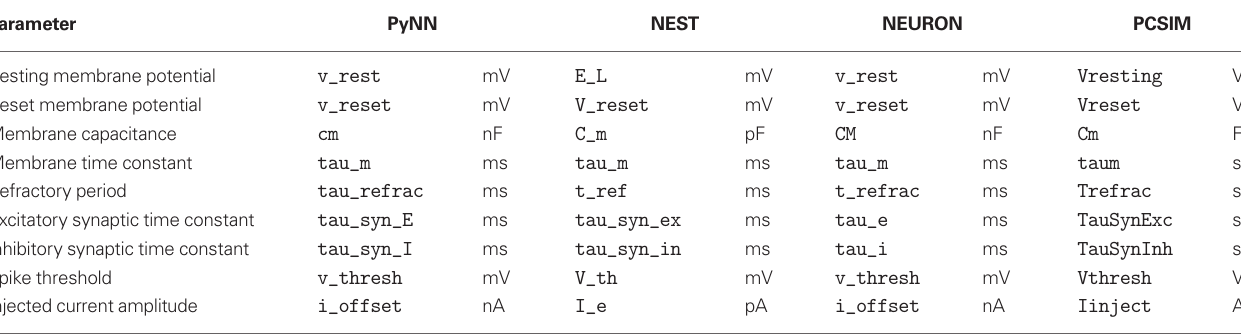
Table 1 | Comparison of parameter names and units for different implementations of a leaky integrate-and-fi re model with a fi xed fi ring threshold and current-based, alpha-function synapses. This model is called IF_curr_alpha in PyNN, iaf_psc_alpha in NEST, LIFCurrAlphaNeuron in PCSIM and StandardIF in NEURON (this is a model template distributed with PyNN and is not in the standard NEURON distribution). Manual conversion of names and units is straightforward but error-prone and time-consuming. PyNN takes care of such conversions transparently. Parameter PyNN NEST